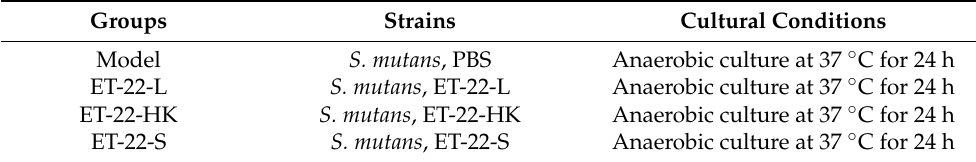
Table 3. Group setting and culture of biofilm